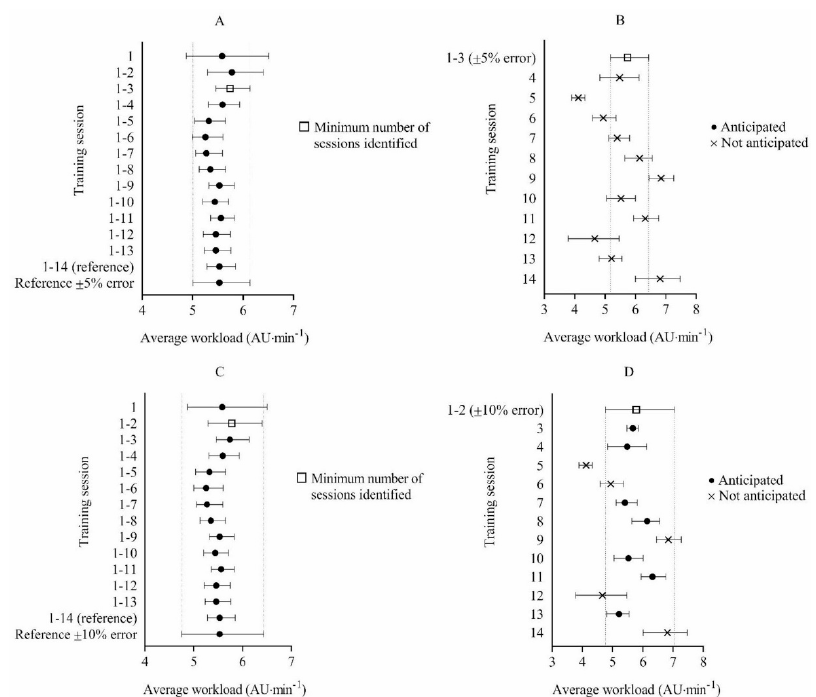
Figure 1. Bootstrap mean workload and bias-corrected 95% confidence intervals (CI) for determining